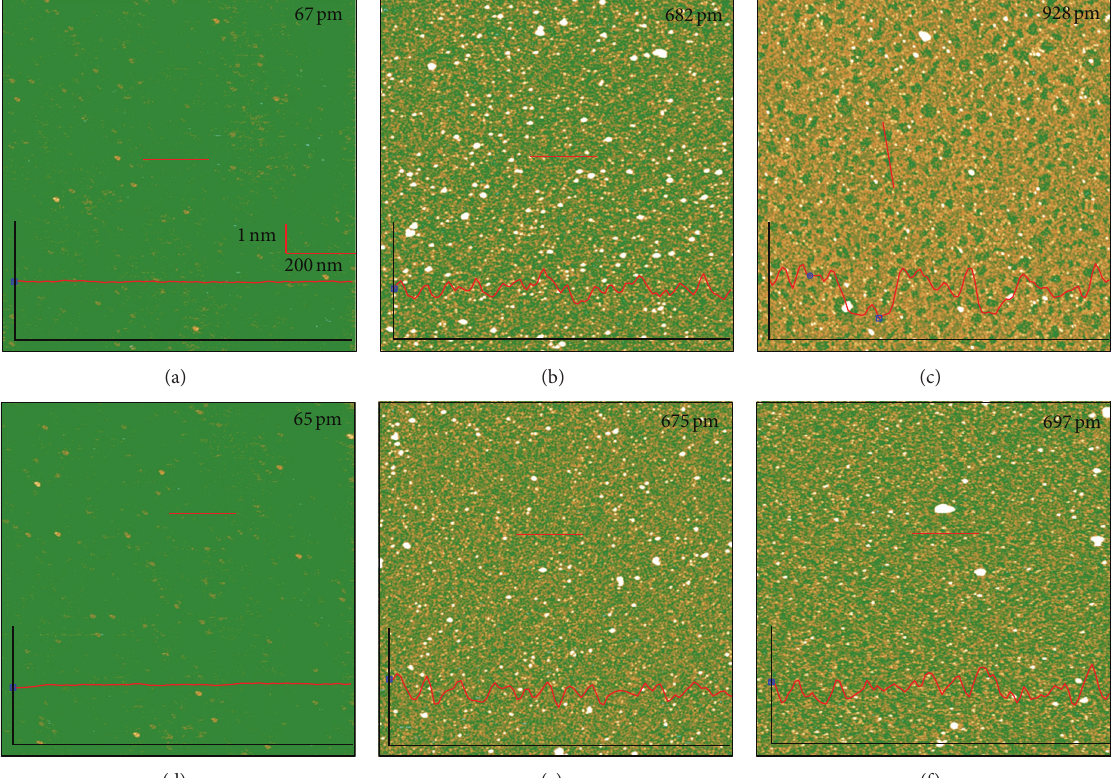
Figure 3: Topographic images (height data) (a, d) of an APS-modified silicon surface. Topographic images (b, e) of a Con A/APS/Si wafer. Upper right hand corner shows the surface roughness of the scanned area. Images (c) and (f) show the Con A/APS/Si wafer after exposure to glucose and galactose, respectively. The glucose-exposed surface exhibits a significantly modified topography, while no change is observed for the sample exposed to galactose. All images are 5 × 5 𝜇 m 2